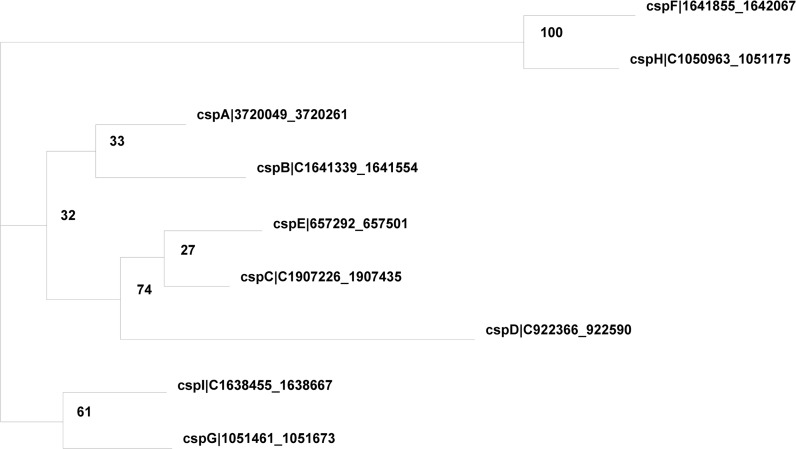
Phylogenetic relationship among paralogous genes cspA to cspI in E. coli, based on coding sequences, with bootstrap values next to internal nodes. Sequences were aligned by MAFFT (Katoh and Toh 2008) with accurate L_INS-i option and a maximum of 16 iterations. Coding sequences were first translated in amino acid sequences, which are aligned with BLOSUM62 matrix. Nucleotide sequences were then aligned against aligned amino acid sequences. Phylogenetic analysis was done with PhyML (Guindon et al. 2010). All these analyses were automated in DAMBE (Xia 2013, 2017).